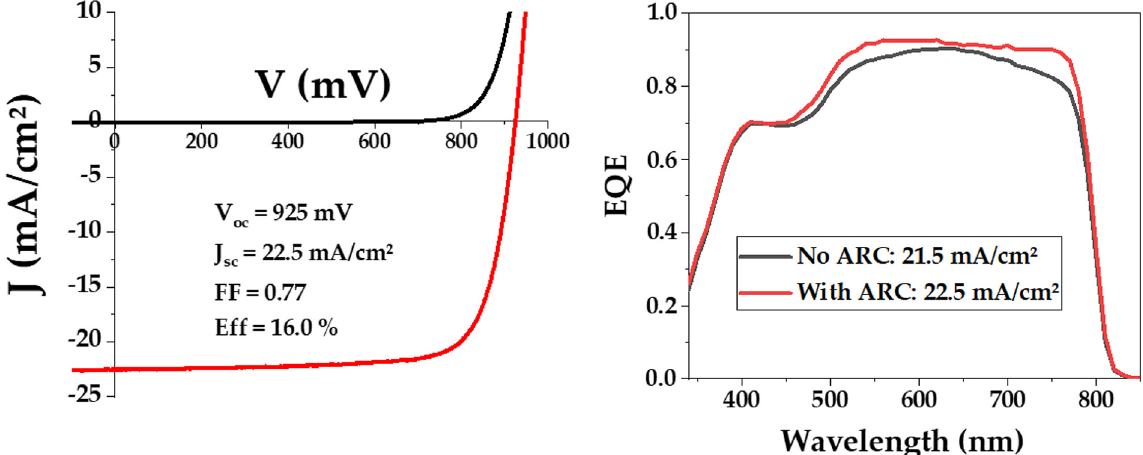
Fig. 6. JV characteristic of the best solar cell buffered with (CBD)CdS. Inset are presented the photovoltaic parameters deduced from the JV curve and the EQE (with ARC).